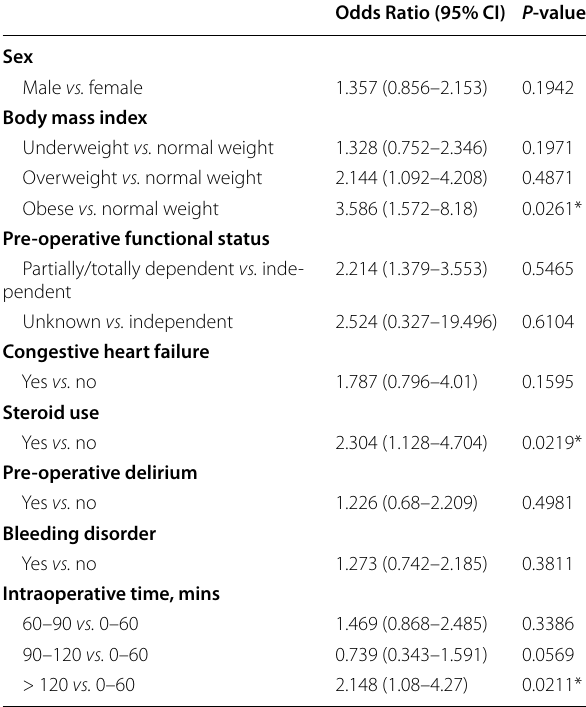
Abbreviations : SSI Surgical site infection, 95% CI 95% confidence interval *Statistically significant ( P <